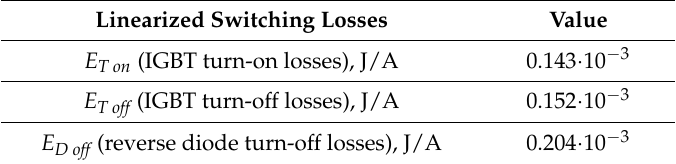
Table 7. Parameters from the IGBT and diodes switching losses